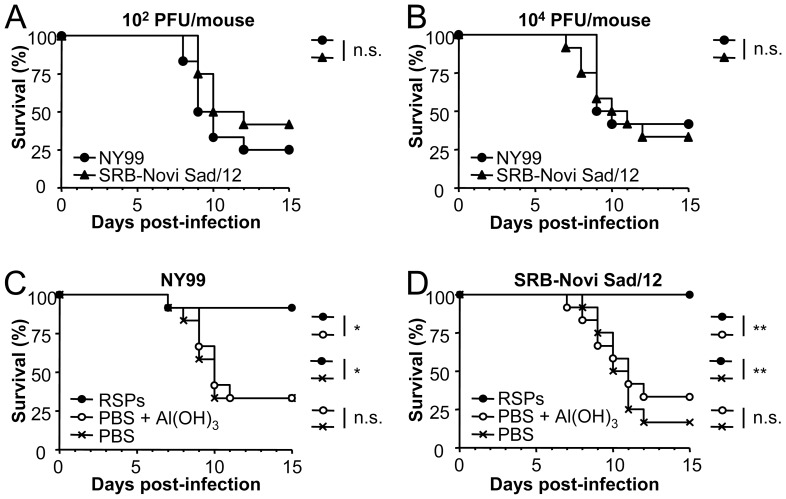
Protection conferred by RSPs against WNV strains from lineage 1 or 2.(A, B) Comparison of the virulence in mice of two distinct WNV isolates. Groups of 12 eight-week old Swiss female mice were infected in parallel with 102 (A) or 104 (B) PFU/mouse of WNV NY99 (lineage 1) or SRB-Novi Sad/12 (lineage 2) and the mortality was recorded along time. (C, D) Protection conferred by the immunization with RSPs against a lethal WNV challenge. Groups of 12 mice were inoculated intraperitoneally with PBS alone, PBS plus Al(OH)3, or 2 µg of purified RSPs plus Al(OH)3 and challenged (two weeks post-inoculation) with 104 PFU/mouse of WNV NY99 (C) or SRB-Novi Sad/12 (D). Statistically significant differences are indicated by one asterisk (*) for P<0.05 or two asterisks (**) for P<0.005. n.s. denotes not statistically significant differences.